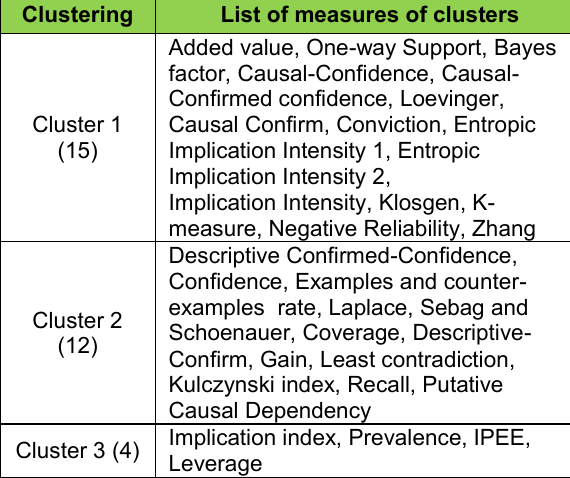
Table 4: The clustering results of measures based on Euclidean distance (h=4).